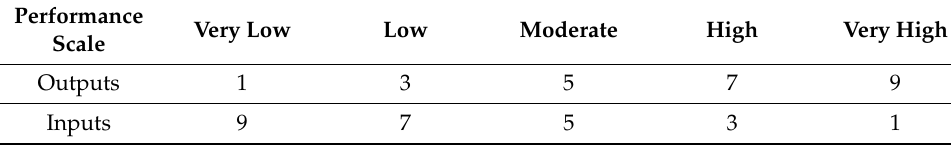
Table 12. Performance scales for inputs and outputs.